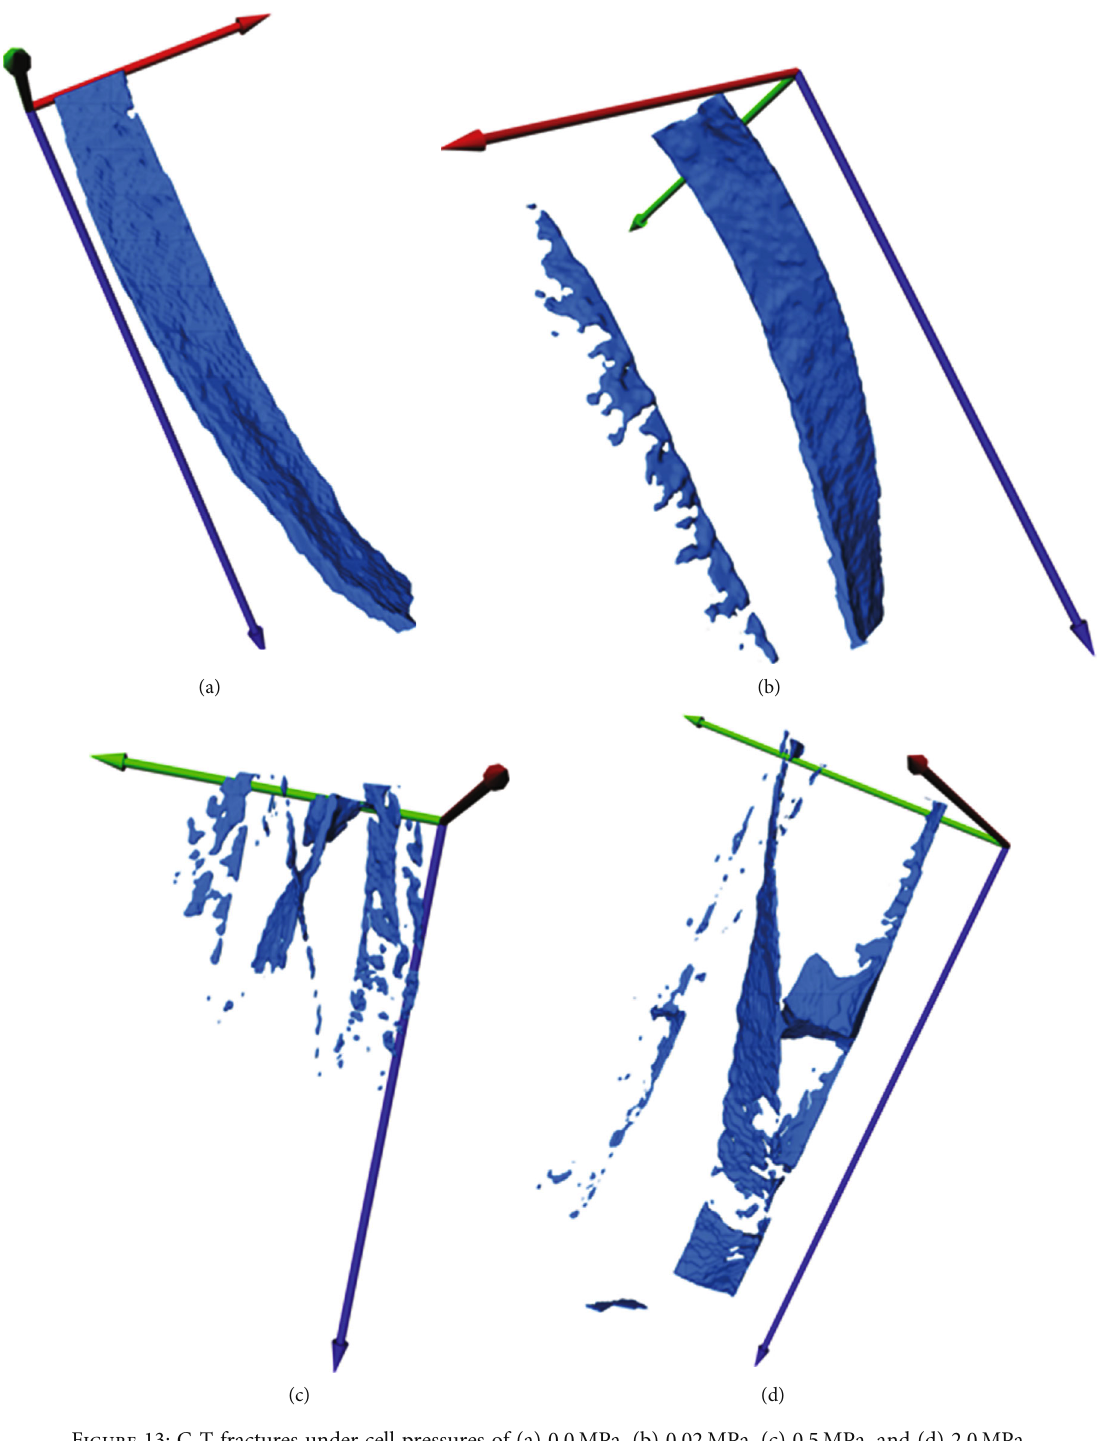
Figure 13: C-T fractures under cell pressures of (a) 0.0MPa, (b) 0.02 MPa, (c) 0.5MPa, and (d)